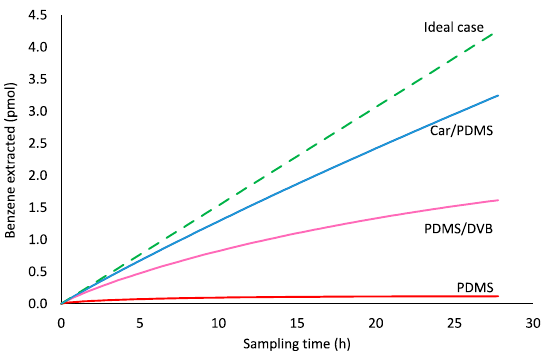
Figure 2. Benzene sampling profiles from ambient air ( T = 298 K, Z = 10 mm, 24 ga needle, p = 1 atm, C benzene = 0.641 µ mol · m − 3 ) obtained using different fiber coatings. The ideal case pertains to Equation (1).